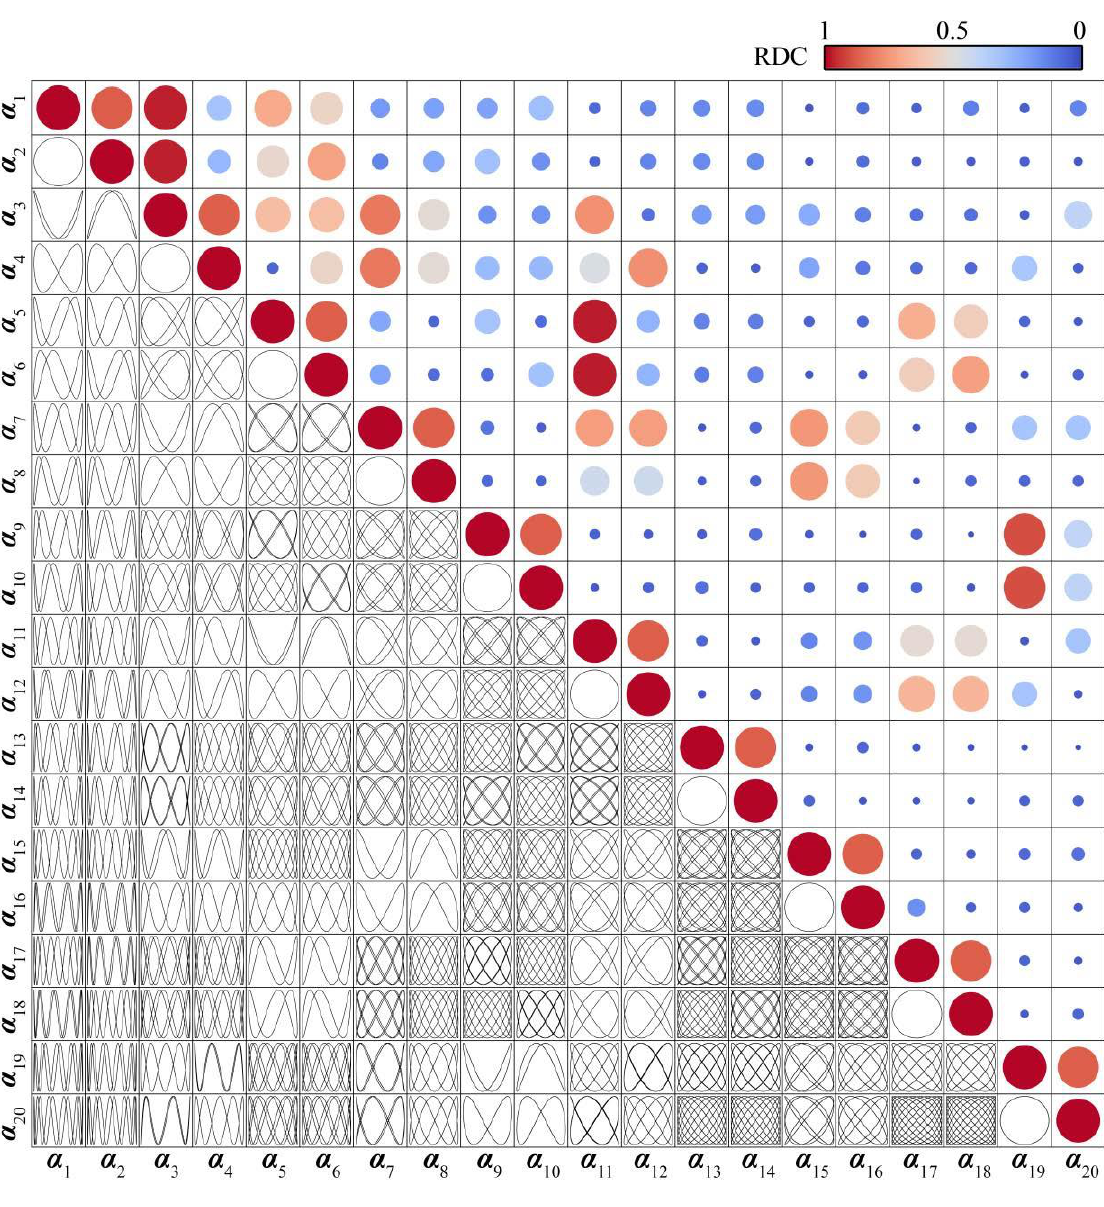
Figure 9. The Lissajous orbits (lower left corner) and RDC distribution (the upper right corner) for the NACA4412 airfoil.